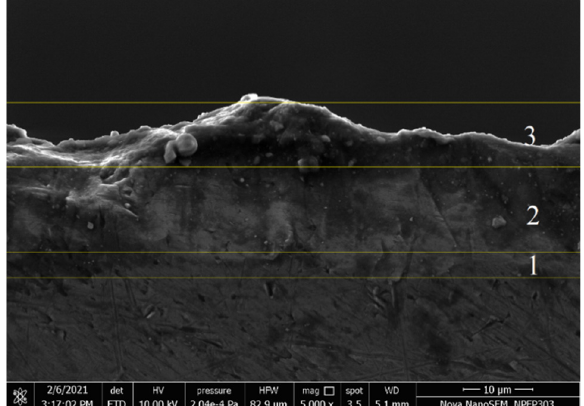
Figure 4. The formation of three characteristic layers in the PEO process. 1. Transition layer; 2. Functional layer; 3. Porous